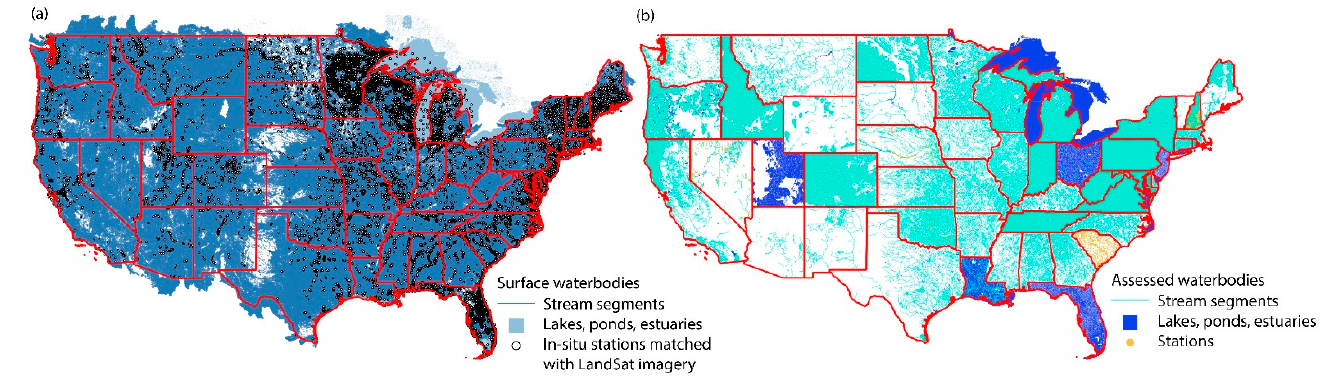
Figure 1. Assessment and in - situ monitoring gap for water quality in the United States: ( a ) 39.6 million stream segments, ponds, lakes and estuaries in the National Hydrography Dataset and 603,433 in-situ monitoring locations from the AquaSat database for Secchi disk depth, Chlorophyll- a , total suspended solids and dissolved organic carbon that have been matched to landSat scenes, and ( b ) the 430,893 assessed waterbodies in the United States obtained from the United states Envi- ronmental Protection Agency’s Assessment and Total Maximum Daily Load Tracking and Imple- mentation System (ATTAINS) database. Red lines indicate state